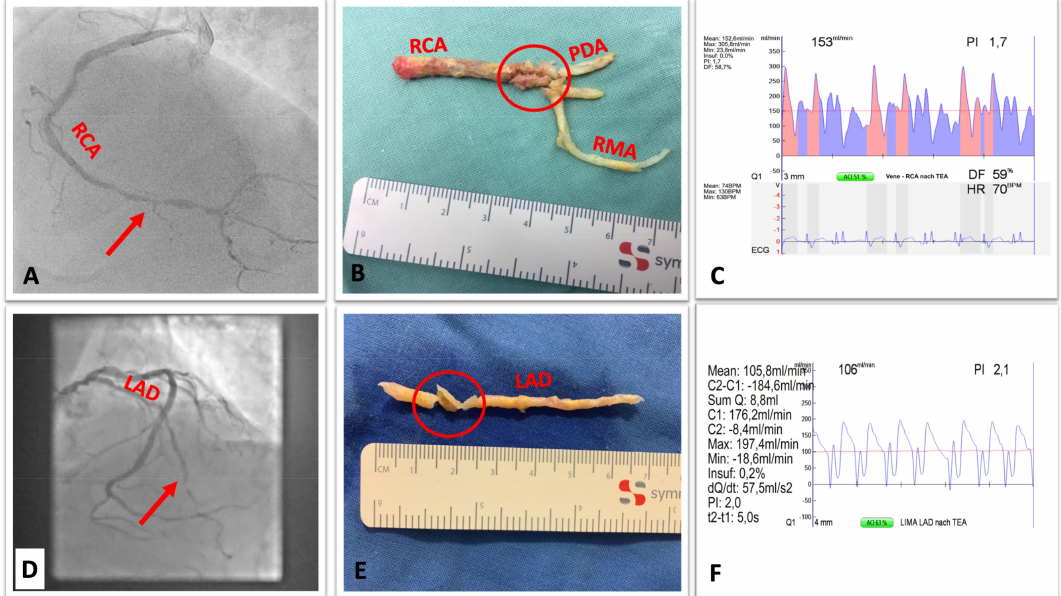
Figure 1. Various atheromatous cylinders extracted from different coronary-territories. Legend: The red arrow and the red circle refers to the site of incision, ( A ) angiography showing diffusely atherosclerotic RCA, ( B ) shows extracted cylinder from the main RCA and its trifurcation, ( C ) Pot- operative TTFM and PI within SVG → RCA bypass after CEA. ( D ) Angiography showing subtotal LAD occlusion, ( E ) shows the extracted atheroma from the LAD, ( F ) Postoperative TTFM and PI of the LIMA → LAD bypass after CEA. RCA = right coronary artery, PDA = posterior descending artery, RMA = right marginal artery, TTFM = transit time flow measurement, PI = pulsatility in- dex, LAD = left anterior descending artery, SVG = saphenous vein grafting, LIMA = left internal mammary